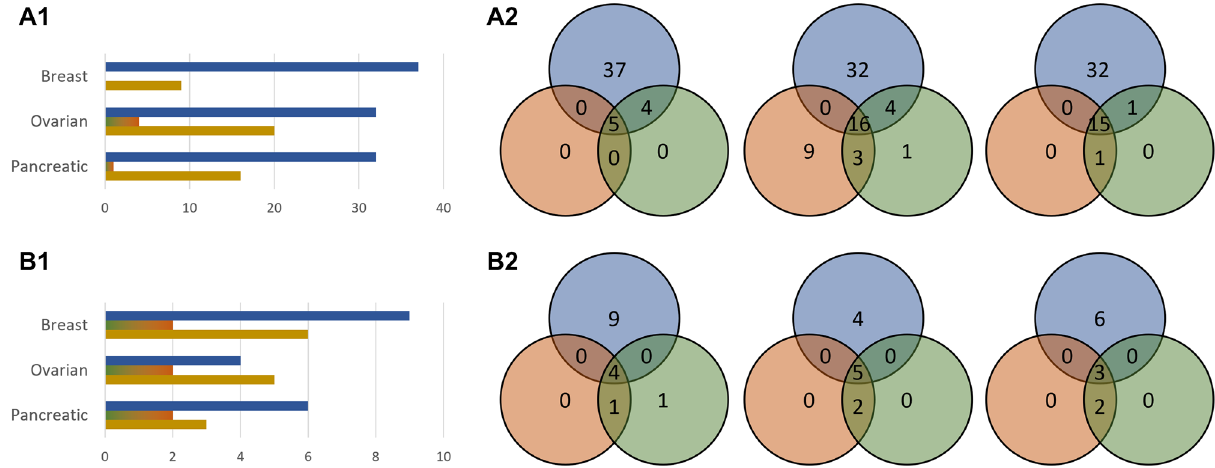
Figure 5. The identified drug-targets over repeated iterations for each algorithm. ( A ) Considering the drug- targets identified in at least one iteration by at least one algorithm, ( B ) considering the drug-targets identified in at least half of the iterations by at least one algorithm; column 1: specific-algorithm identified drug-targets, column 2: overlap between identified drug-targets by algorithm; in blue: (constrained) genetic algorithm, in green: constrained greedy algorithm, in orange: unconstrained greedy algorithm, in yellow: the intersection of all